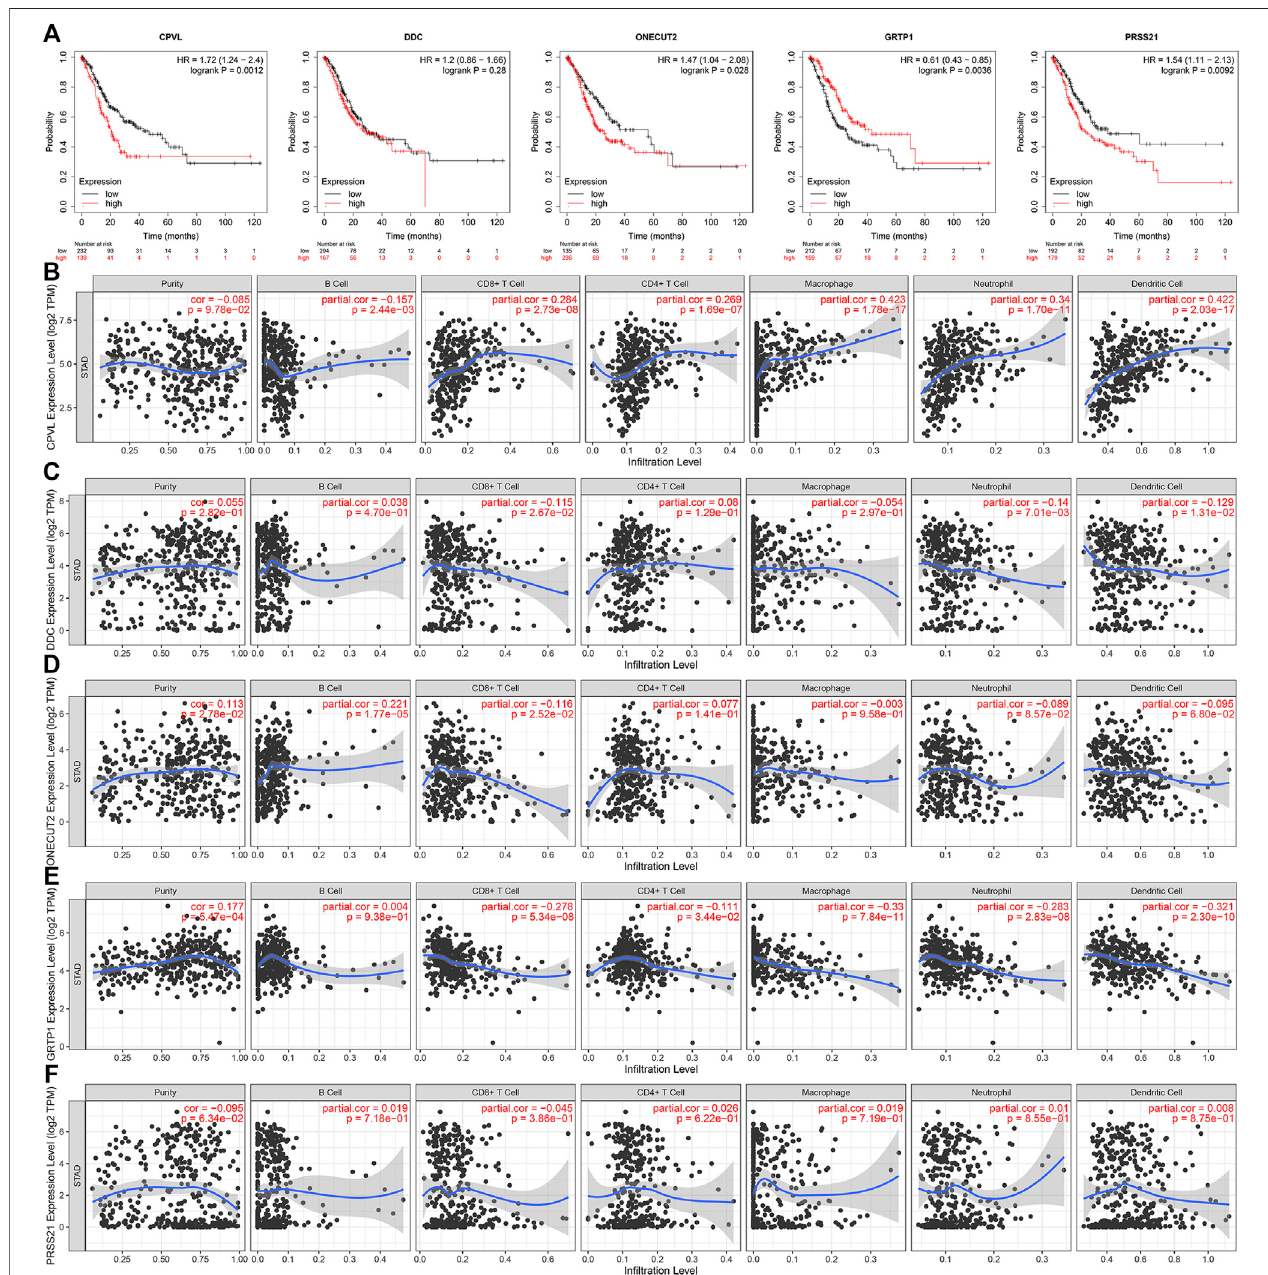
FIGURE 5 | The survival curve of the Hub gene and its relationship with immune cell in fi ltration. (A) The survival curve of CPVL , ONECUT2 , DDC , PRSS21 , and GRTP1 in patients with gastric cancer. (B – F) The correlation of CPVL , ONECUT2 , DDC , PRSS21 , and GRTP1 with neutrophils, macrophages, dendritic cells, B cells, and CD4/CD8 T cells in gastric cancer immune in fi